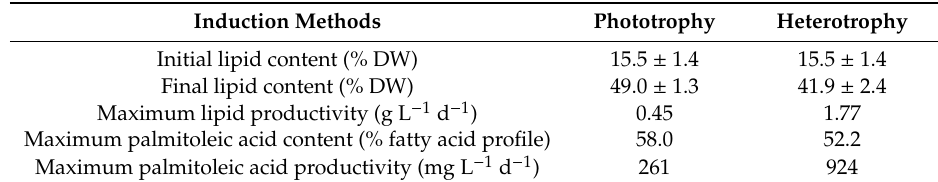
Table 1. Comparison between the phototrophic and heterotrophic methods to promote the lipid of T. minus . Data is presented as an average of three replicates with standard deviation.